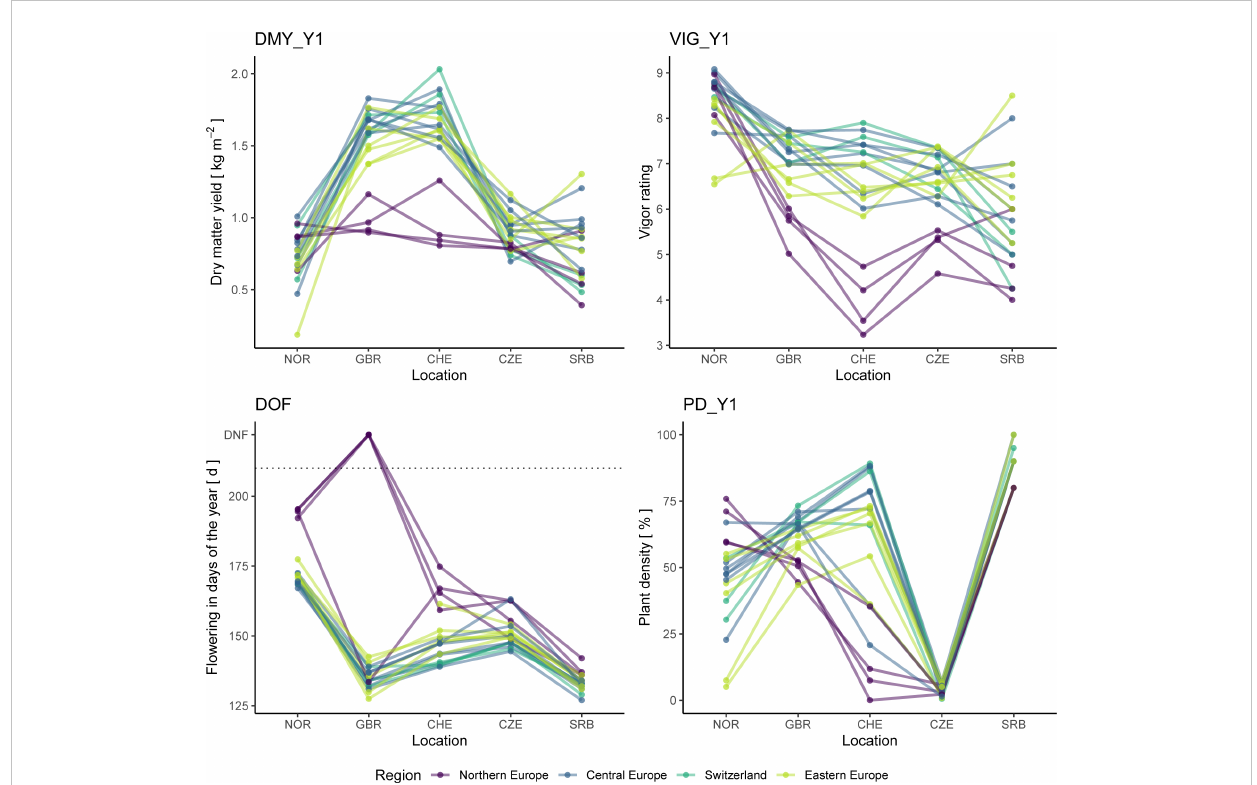
FIGURE 10 Performance of 20 red clover accessions grown in all fi ve fi eld trials. Traits analyzed are total dry matter yield of the fi rst year (DMY_Y1), average vigor of the fi rst year (VIG_Y1), date of fl owering (DOF) as well as plant density after the fi rst year (PD_Y1). In the plot of DOF, accessions that did not fl ower are displayed with a value of 222 and are labelled accordingly (DNF). Accessions are colored according to their region of